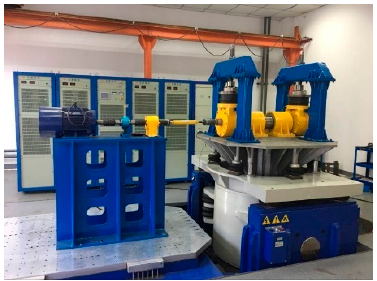
Figure 12. The experimental station of high-speed train axle box bearing.